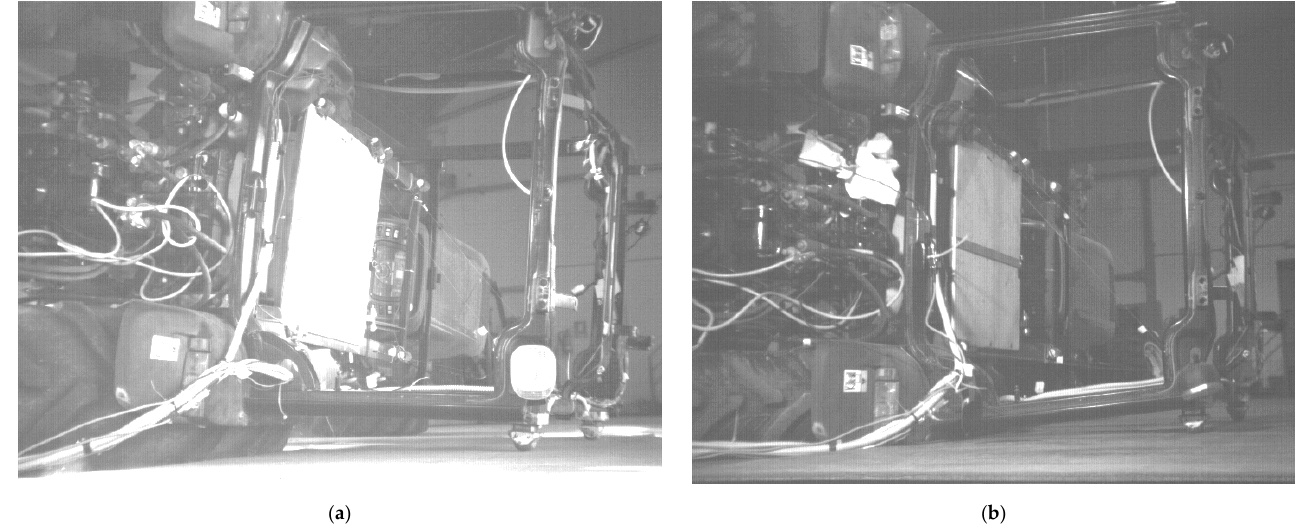
Figure 7. Close-up views of ROPS contact for the: T1 wide configuration ( a ), and T2 narrow configuration ( b ).